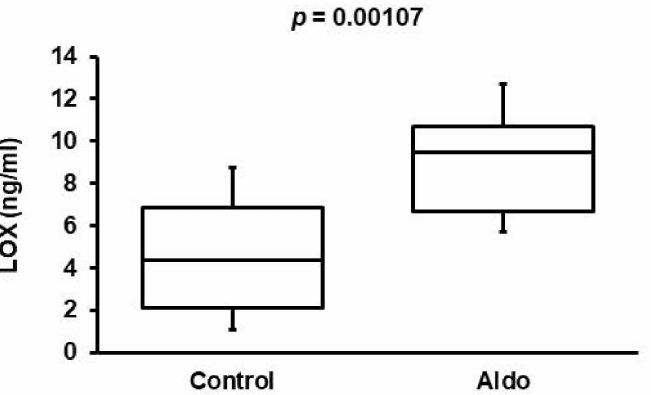
Figure 2. Effect of aldosterone blockade on serum concentrations of LOX in DCM patients. LOX serum concentrations in patients from cohort 2 (DCM) either without (control; n = 17) or with aldosterone blockade (Aldo; n = 19). The box and whiskers plots show the total range (whiskers), Q25, Q50, and Q75. Exact p -value is given.